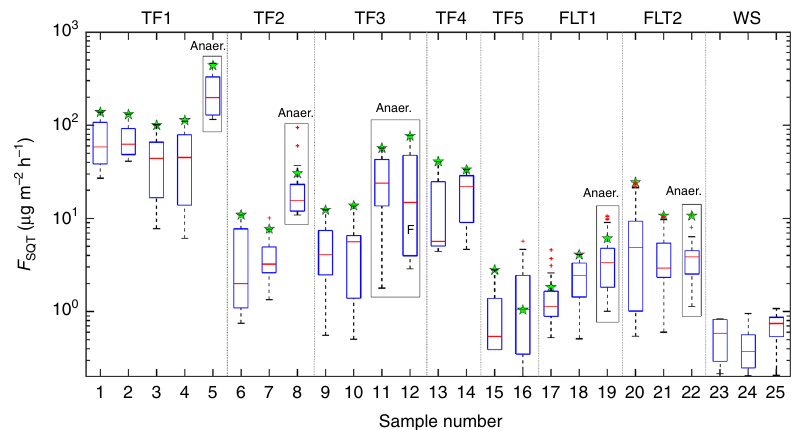
Fig. 3 Organic (O) horizon (0 – 5cm) SQT emissions during a complete dry out. All experiments started from saturated moisture conditions. The data represent the emission rates measured with WFPS>10% apart from the samples S5, S8, S11, and S12 that dried up to WFPS ≈ 45%. On each box, the center line (red) indicates the median, and the bottom and top borders of the box (blue) indicate the 25th and 75th percentiles, respectively. The whiskers extend to the most extreme data points not considered outliers, and the outliers are plotted individually using the “ + ” symbol (red). The boxplot draws points as outliers if they are greater than q3 + w × (q3 – q1) or less than q1 – w × (q3 – q1). q1 and q3 are the 25th and 75th percentiles of the sample data, respectively. The “ Whisker ” ( w ) corresponds to ±2.7 σ and 99.3% coverage if the data are normally distributed. The green markers indicate the optimum SQT fl ux (in μ g m − 2 h − 1 ). The large boxes around S5, S8, S11, S19, and S22 indicate that these experiments were conducted under anaerobic conditions. The symbol F indicates that sample S12 was fl ooded to three times its water holding capacity and allowed to dry under zero air as dilution gas